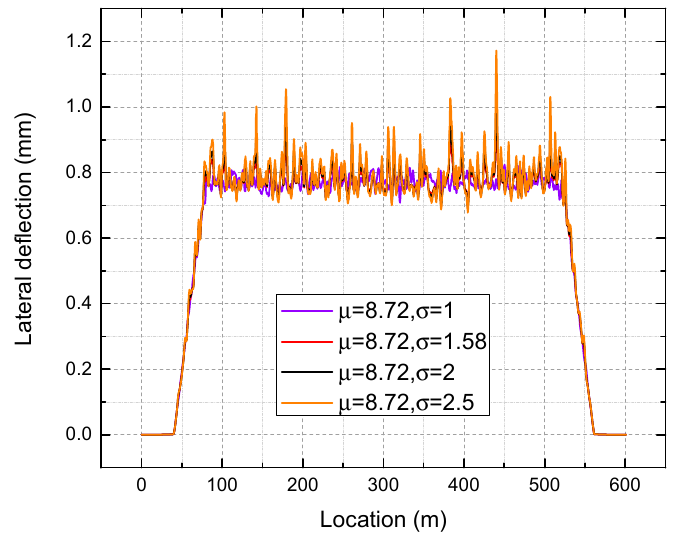
Figure 18. Lateral deflection under different standard deviations. The maximum, minimum, mean, and standard deviations of lateral deflection are presented versus the standard deviation of input lateral ballast resistance in Figure 19.